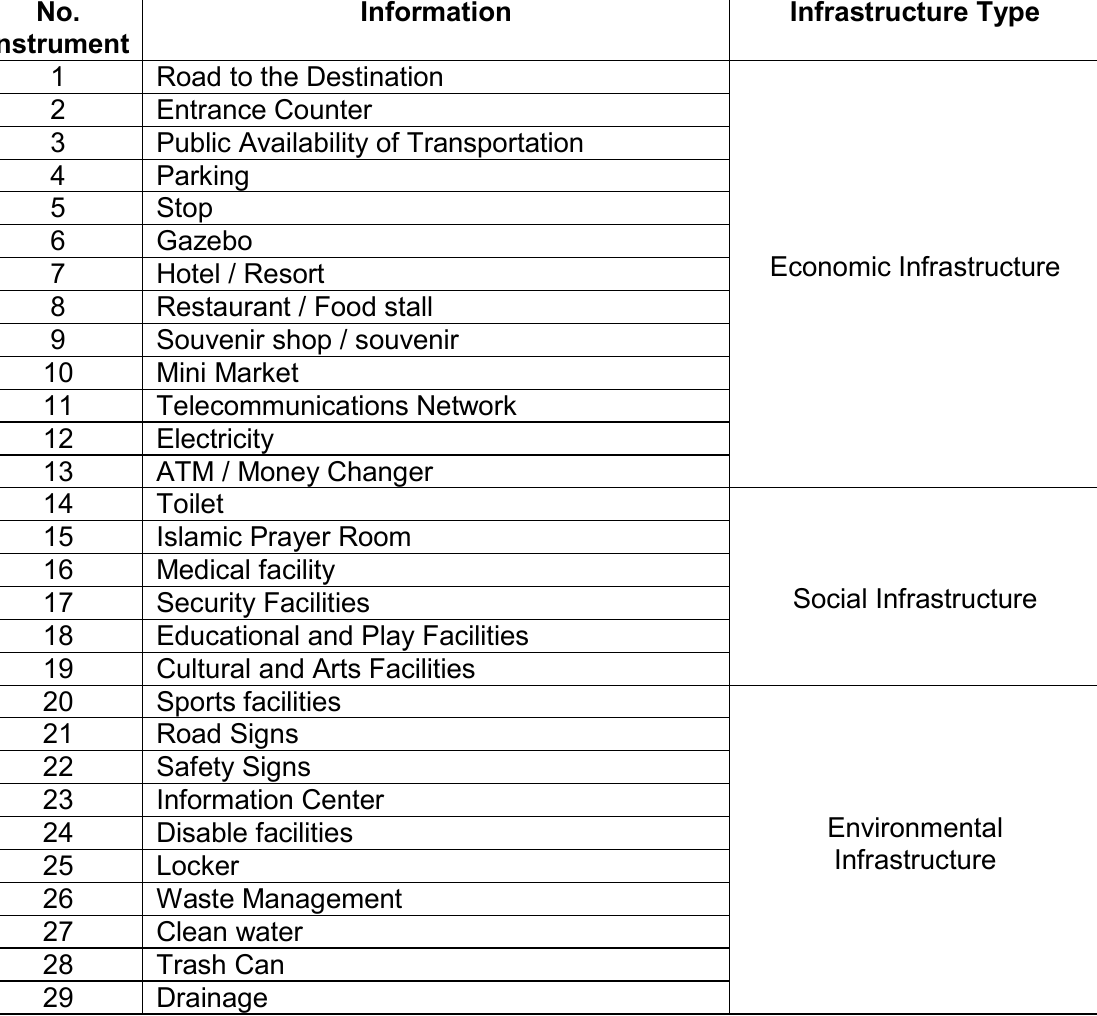
Table 1. Data Infrastructure Economic, Social and